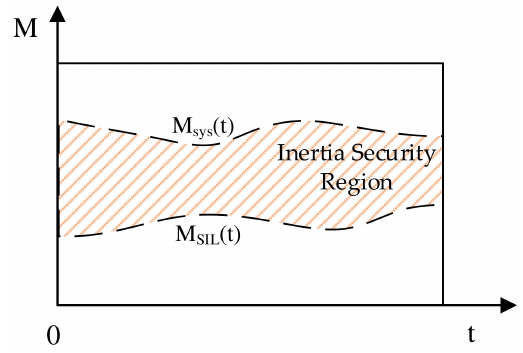
Figure 5. Inertia security region of the